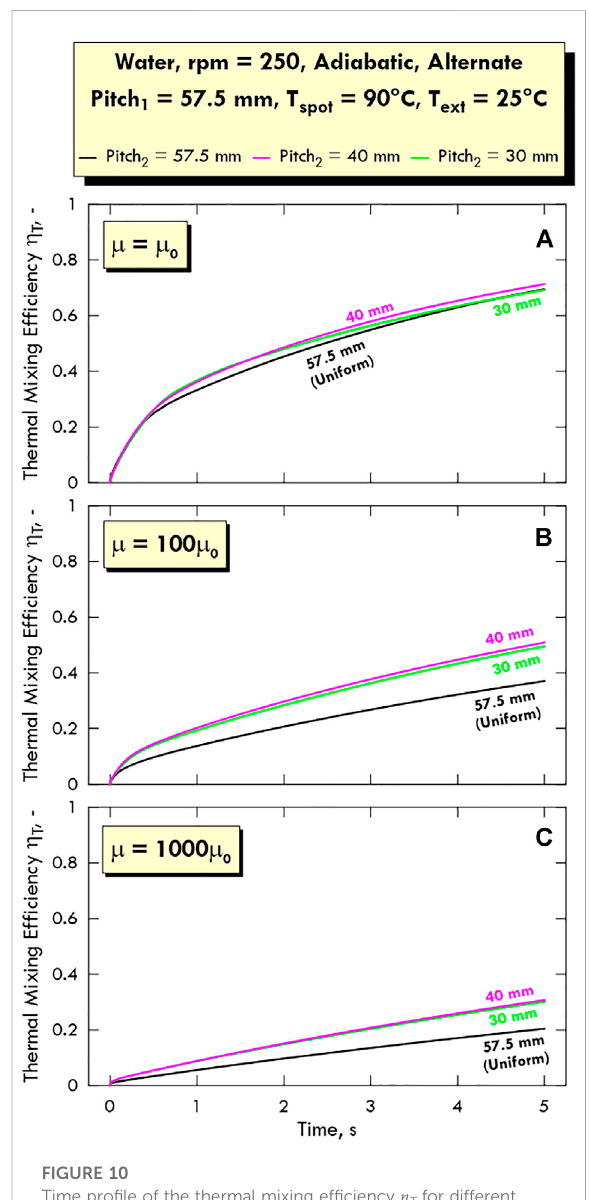
FIGURE 10 Time pro fi le of the thermal mixing ef fi ciency η T for different values of pitch in alternate con fi guration at different values of viscosity μ . Fluid: water, T spot = 90 ° C, T ext = 25 °